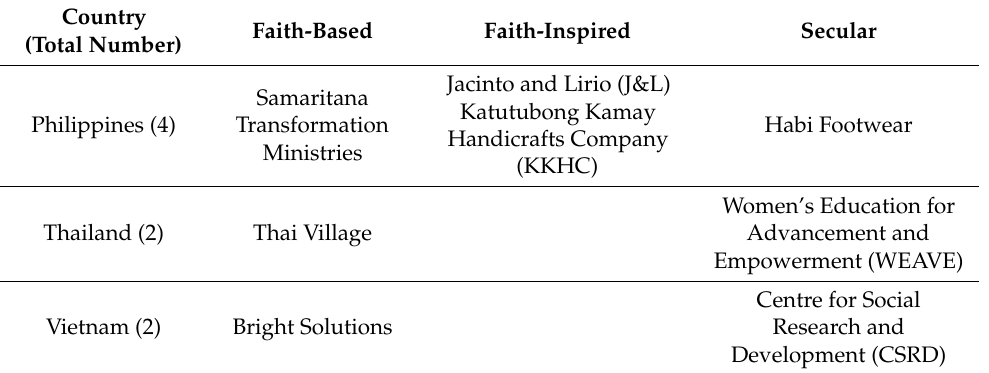
Table 1. Categorisation of